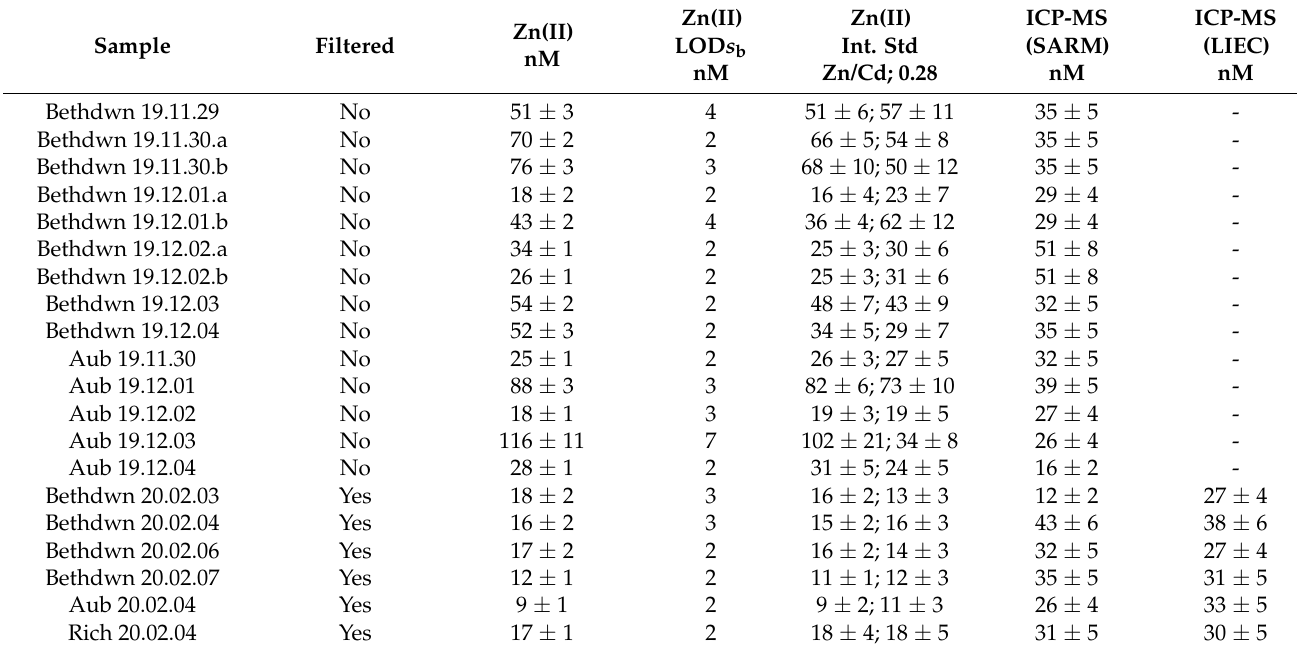
Figure 2. SCP curves obtained for the unfiltered river sample (Aub 19.12.04), ( t d :90 s) and E d of − 1.25 V at pH 3.5 for the initial sample and standard additions of Cd(II) ( − 0.55 V peak), Pb(II) ( − 0.37 V peak) and Zn(II) ( − 0.95 V peak). Two standard additions were omitted to simplify the data presentation. Table 5. Zn(II) results obtained for and standard addition and internal standard methods ( t d : 90 s) in the river samples (acidified to pH 3.5) and the ICP-MS results obtained in the filtered, strongly acidified samples. a and b written after the sample names refer to replicate